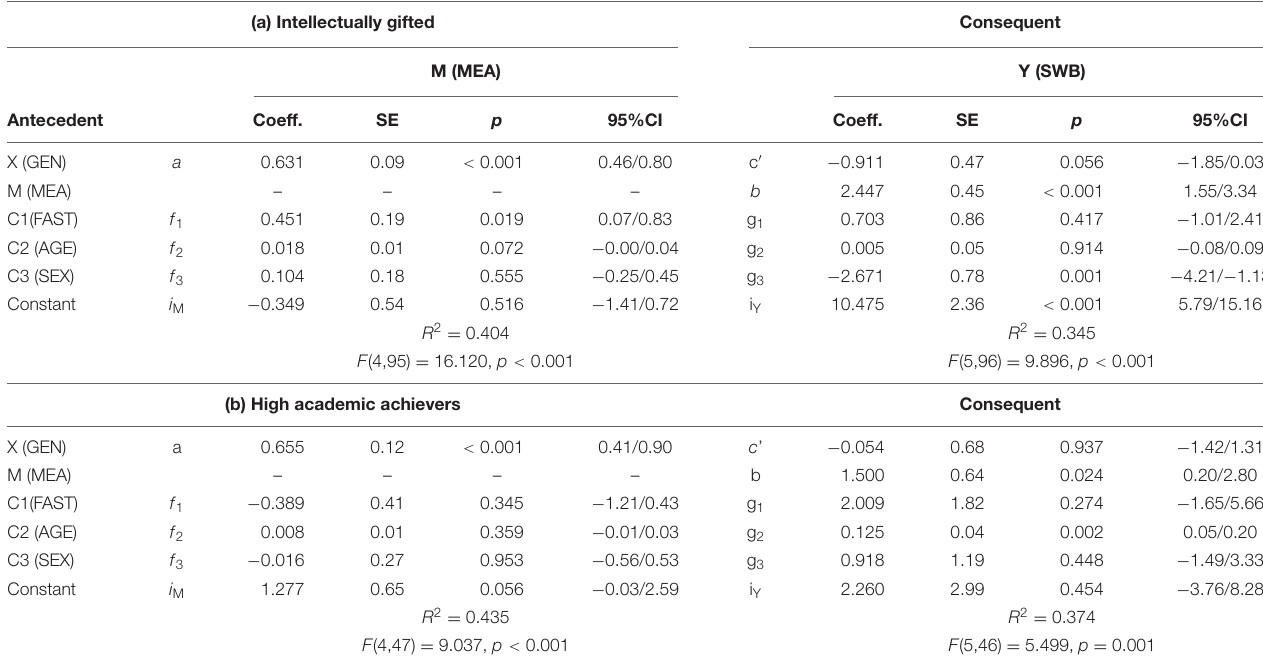
TABLE 3 | Simple mediation model and unstandardized model coefficients among (a) intellectually gifted and (b) high academic